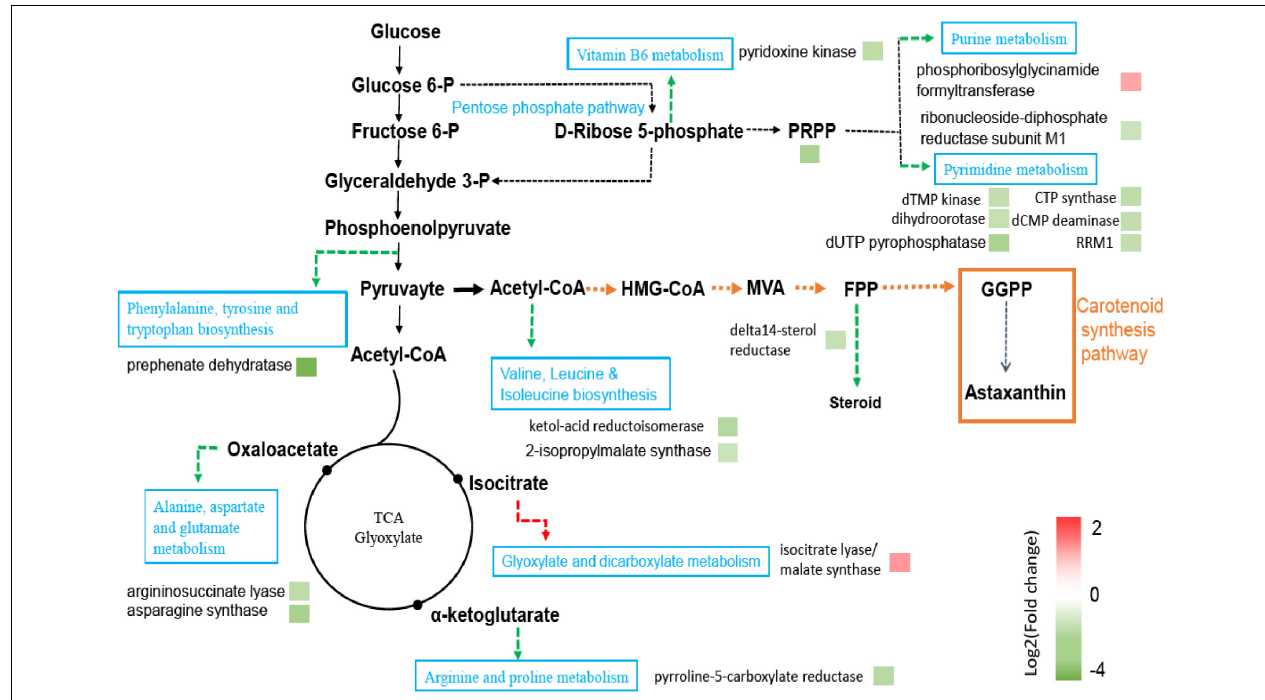
FIGURE 5 | Pathways of significantly differentially expressed genes between F94 strain and PR strain. Protein names were inferred from KEGG orthologs. Upregulation of genes encoding proteins were shown in red and downregulation of genes encoding proteins were in green.